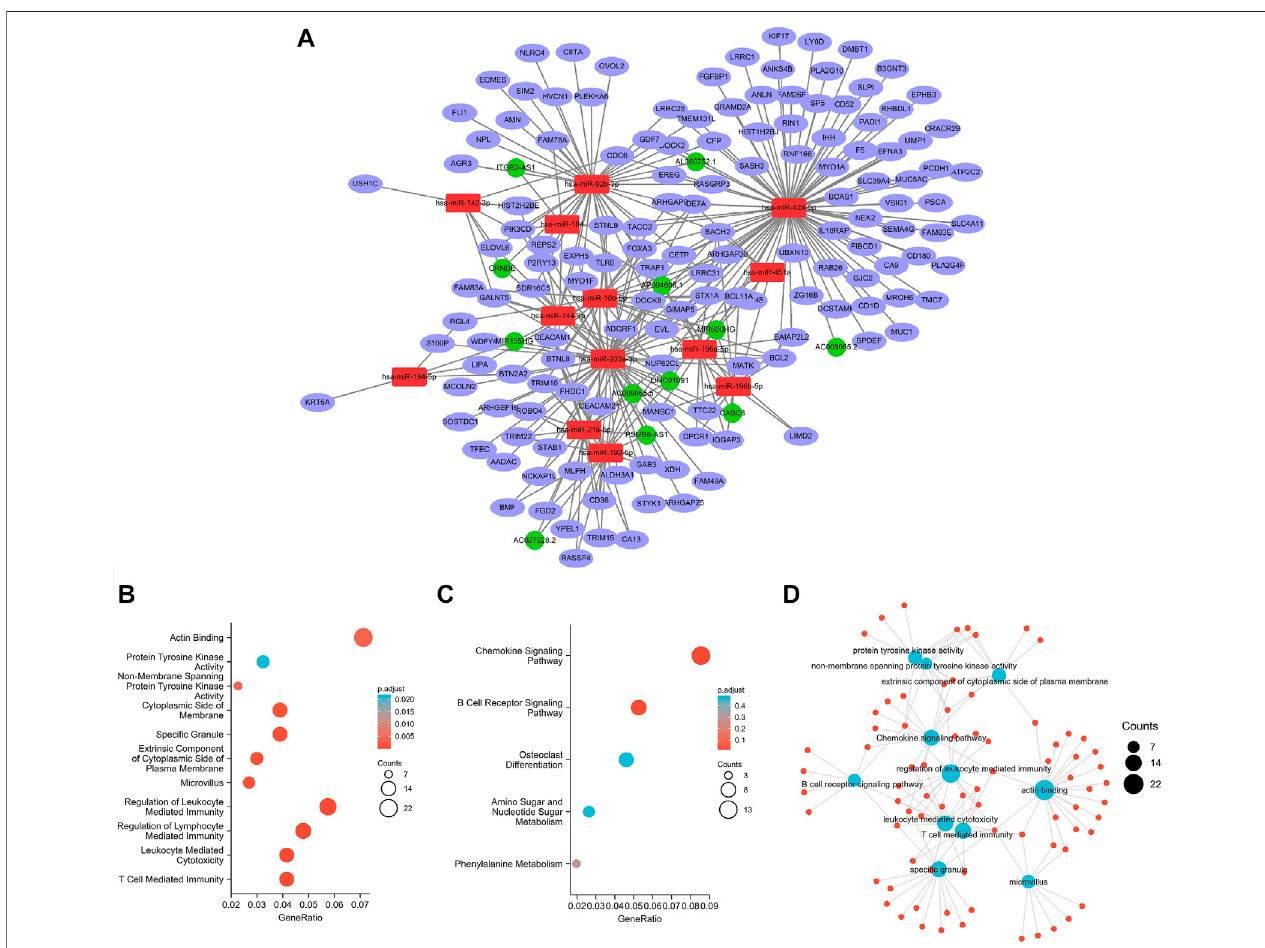
FIGURE3| ConstructedceRNAnetworksviaCytoscape (A) ;GO (B) andKEGG (C) analysesforceRNA-relateddifferentiallyexpressed genes;visualnetwork (D) .